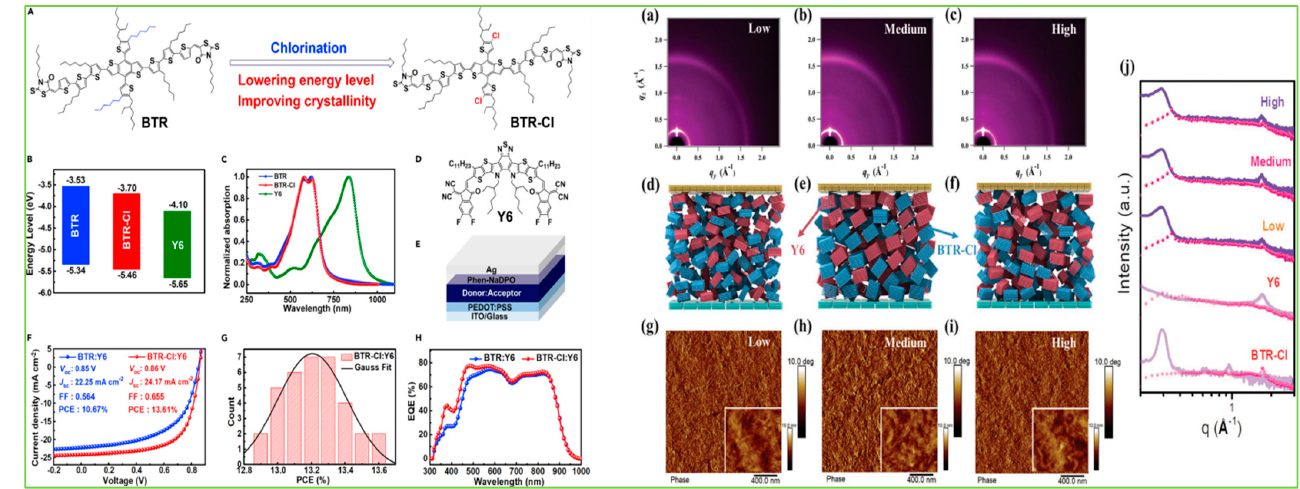
Figure 10. ( A ) Property improvement of BTR by chlorination. ( B ) Energy level diagram of BTR, BTR-Cl, and Y6. ( C ) Film absorption of donor and acceptor materials. ( D ) Molecular structure of Y6. ( E ) Device structure of the ASM OSC. ( F ) J-V curves of the best-performing BTR: Y6 and BTR-Cl: Y6-based ASM OSC. ( G ) Histogram of PCE counts for 35 individual devices with the BTR-Cl:Y6 active layer. ( H ) EQE curves of the best-performing devices. Adapted with permission from [38]. Copyright 2019, CellPress. Two-dimensional GIWAXS patterns of films based on BTR − Cl: Y6 blend of ( a ) low concentration, ( b ) medium concentration, and ( c ) high concentration. The schematic morphol- ogy based on BTR − Cl: Y6 blend films of ( d ) low concentration, ( e ) medium concentration, and ( f ) high concentration. AFM phase images with height images inset of BTR − Cl: Y6 blend film of ( g ) low concentration, ( h ) medium concentration, and ( i ) high concentration. ( j ) Corresponding GIWAXS intensity profiles along the in-plane (purple lines) and out-of-plane (red lines) directions. Adapted with permission from [39]. Copyright 2020, John Wiley and Sons.